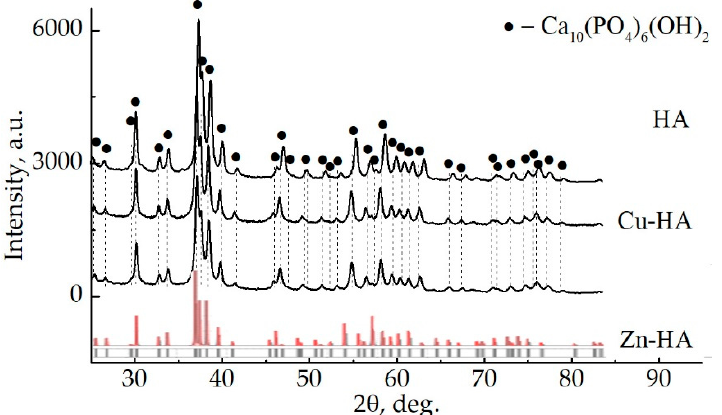
Figure 3. XRD patterns of HA, Cu-HA, and Zn-HA powders after mechanochemical synthesis (red and gray lines represent HA etalon XRD-pattern according to PDF-card no. 00-009-0432).